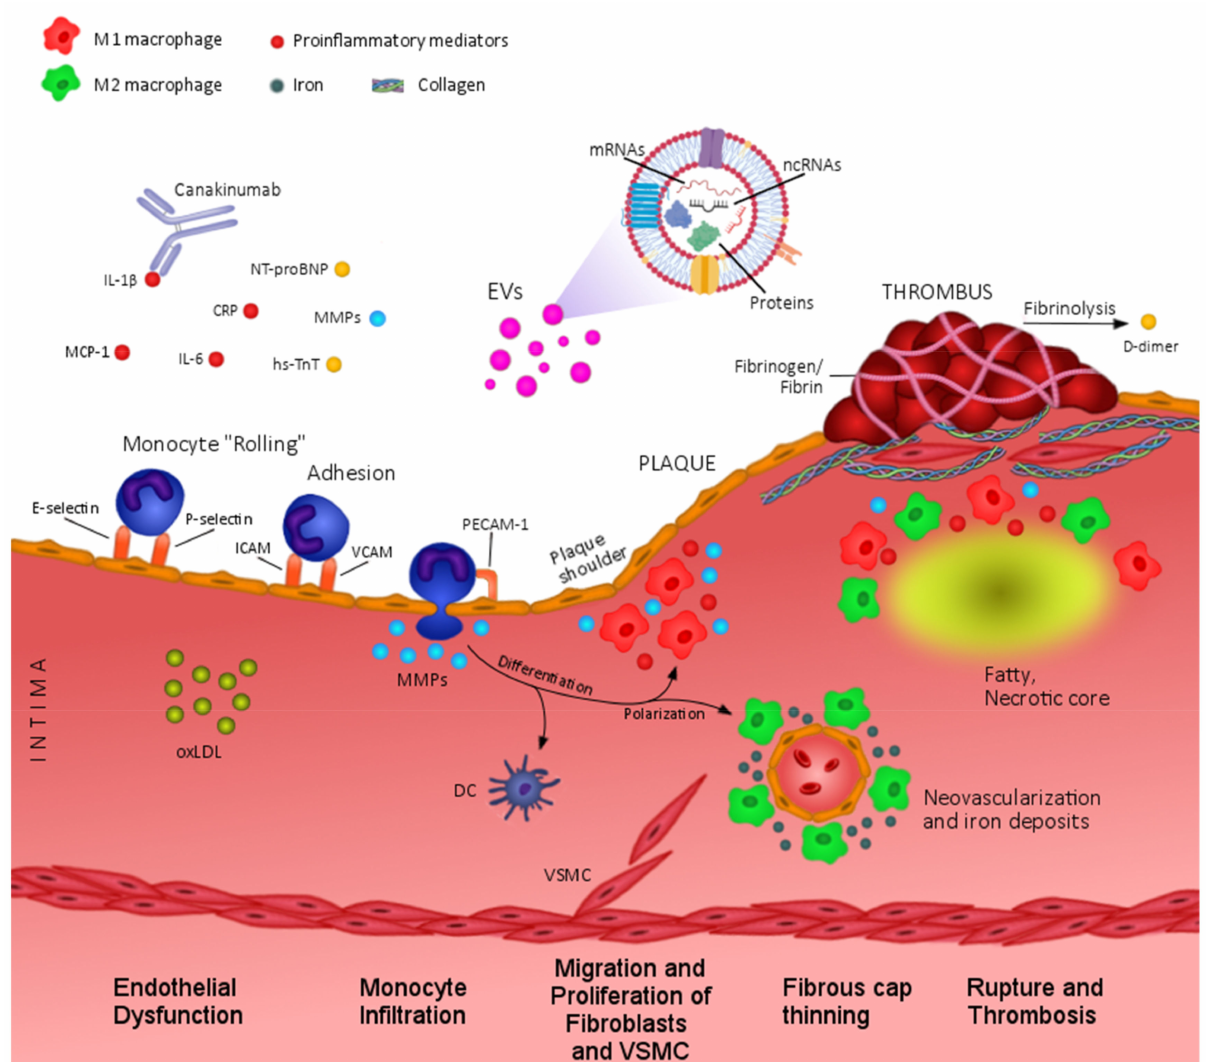
Figure 1. Circulating biomarkers in atherosclerosis and PAD pathophysiology. At early stages of atherosclerosis, endothelial dysfunction leads to increased levels of proinflammatory cytokines (IL1 β , IL6, CRP, MCP-1), extracellular vesicles (EVs), proteases (MMPs), and adhesion molecules (E-selectin, P-selectin, ICAM, VCAM,) that contribute to monocyte recruitment and infiltration into the intima. Microenvironmental factors such as MMPs orchestrate plaque progression by regulating macrophage polarization towards proinflammatory (M1) or anti-inflammatory (M2) phenotypes, which are predominantly located in unstable areas (i.e.,: plaque shoulder) or neovascularization regions, respectively. In advanced lesions, inflam- matory factors and MMPs exacerbate fibrous cap thinning and contribute to plaque instability, rupture, and formation of fibrin clot. Extracellular vesicles (EVs), mainly of platelet origin, also participate in thrombus formation according to the exposure of procoagulant factors (e.g.,: tissue factor and phosphatidylserine). In addition, reduced tissue perfusion due to arterial stenosis and thrombosis might cause increased levels of tissue damage-related biomarkers such as NT-proBNP or hs-TnT. CRP, C reactive protein; DC, dendritic cells; ICAM, intercellular adhesion molecule; IL, interleukin; MCP-1, monocyte chemoattractant protein; MMPs, matrix metalloproteinases; NT-proBNP, N-terminal pro-brain natriuretic peptide; oxLDL, oxidized Low Density Lipoproteins; hs-TnT, high sensitivity troponin T; VCAM, vascular cell adhesion molecule; VSMC, vascular Smooth Muscle